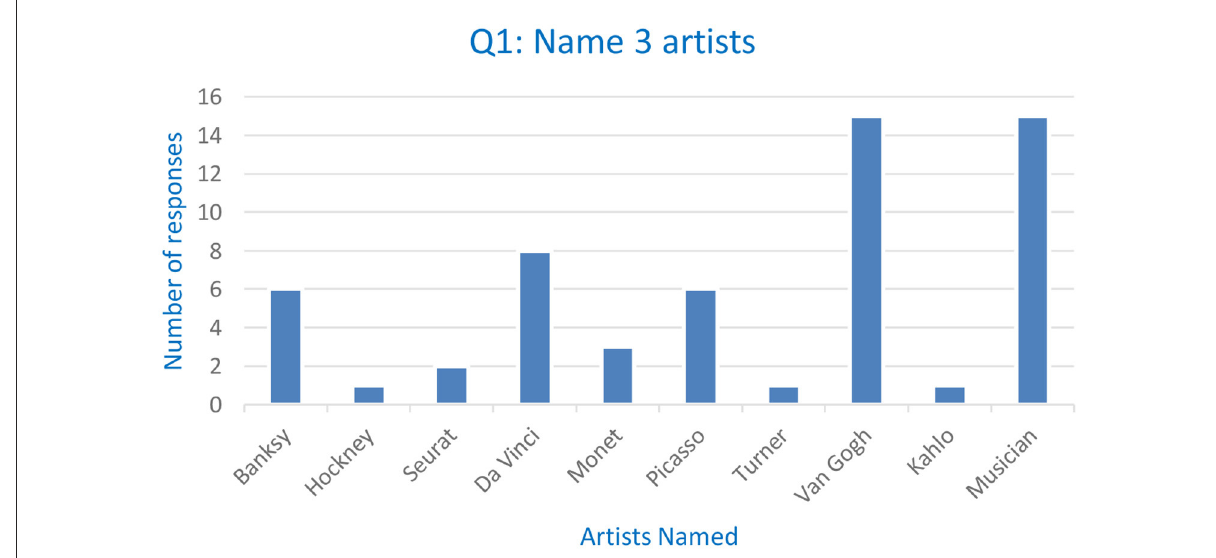
FIGURE1 Survey results demonstrating students’ knowledge of artists (November